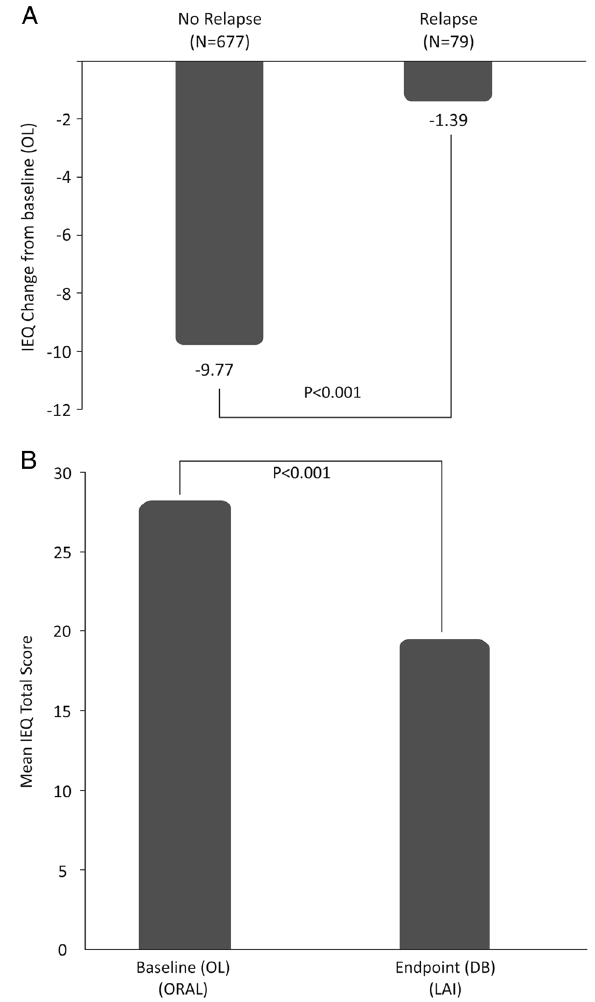
Fig. 2 a IEQ Total score change at double-blind endpoint from open-label baseline, by relapse status. An ANOVA model was fi tted with IEQ total score change at DB endpoint from OL baseline as outcome variable, and study ID and relapse status as factors. b IEQ Total score change at double-blind endpoint from open-label baseline, for patients who were on oral antipsychotics prior to study entry. A mixed model was fi tted with IEQ total score as the outcome variable, and study ID and time points (OL baseline, DB endpoint) as factors. N =